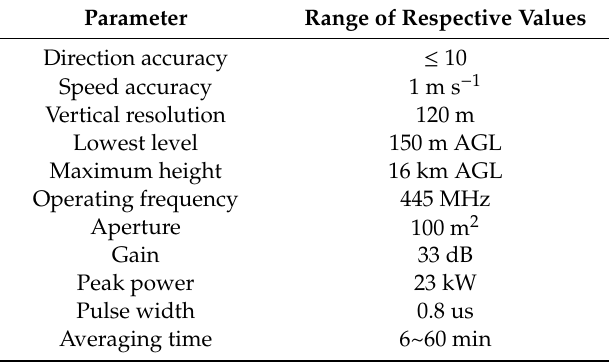
Table 1. Summary of the operating and sampling characteristics of the CFL-16 Radar Wind Profiler (RWP) deployed in Beijing.